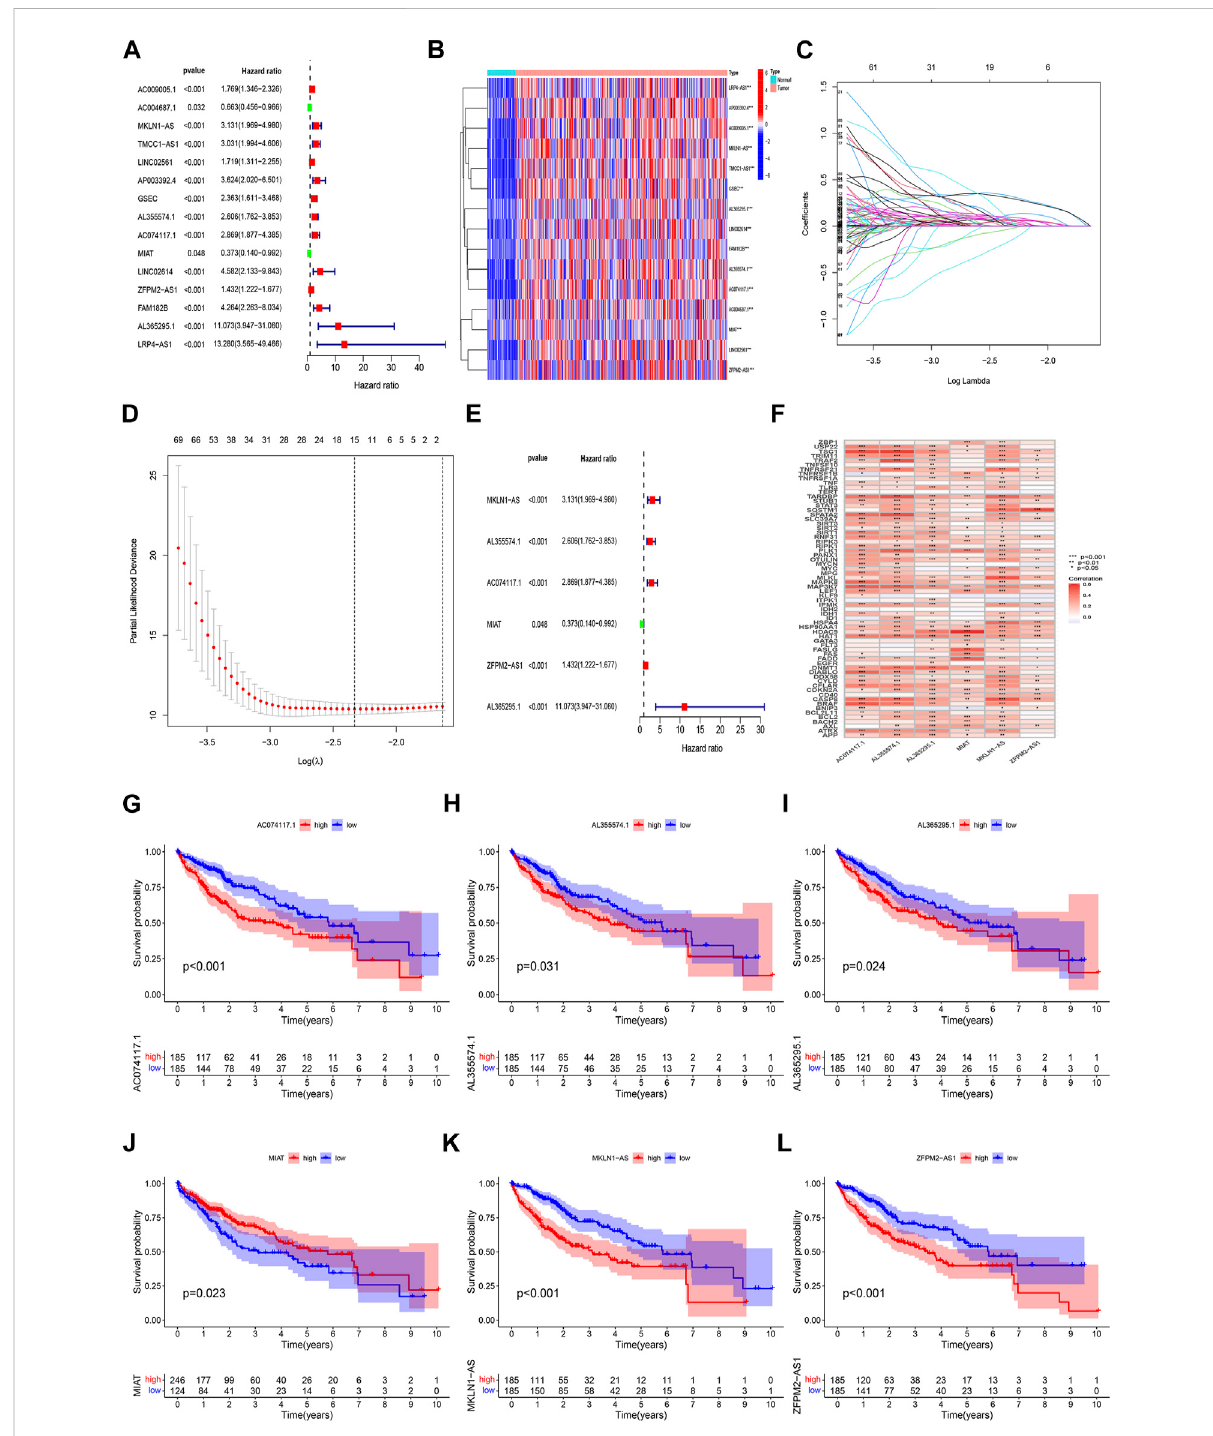
Identi fi cationofprognostic NRlncRNAs (necroptosis-related lncRNAs ). (A) The prognostic lncRNAs obtained byuni-Coxregression analysis; (B) The heatmap of 15 prognostic lncRNAs expression; (C – D) The fi nal NRlncRNAs of the prognostic model was con fi rmed from LASSO regression analysis; (E) six NRlncRNAs oftheriskmodel; (F) Correlationsbetween NRlncRNAs intheriskmodelandnecroptosis-relatedgenes (G) Kaplan – Meier curve of OS analyzed for AC074117.1. (H) Kaplan – Meier curve of OS analyzed for AL355574.1. (I) Kaplan – Meier curve of OS analyzed for AL365295.1. (J) Kaplan – Meier curve of OS analyzed for MIAT. (K) Kaplan – Meier curve of OS analyzed for MKLN1-AS. (L) Kaplan – Meier curve of OS analyzed for